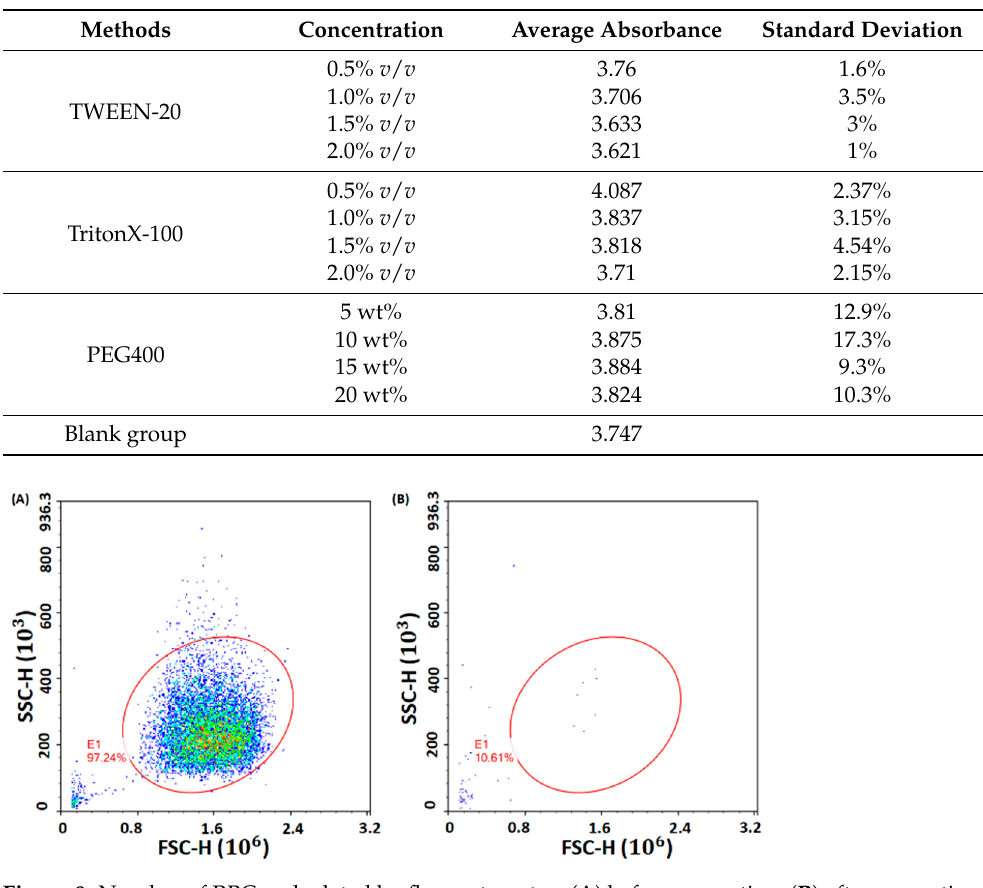
Table 2. Absorbance results.